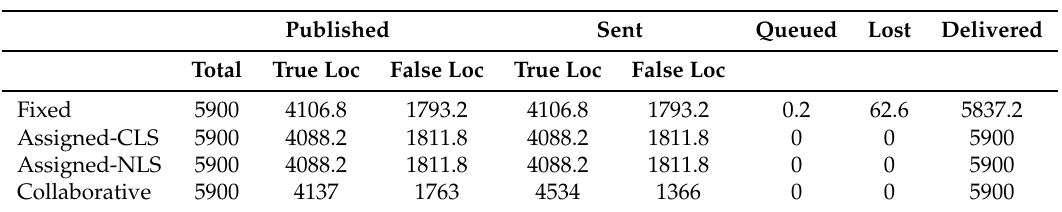
Table 3. Simulation statistics P f = 0.3. (a) Producer and network flow. (b) Delivered notifications with a true location claim. (c) Delivered notifications with a false location